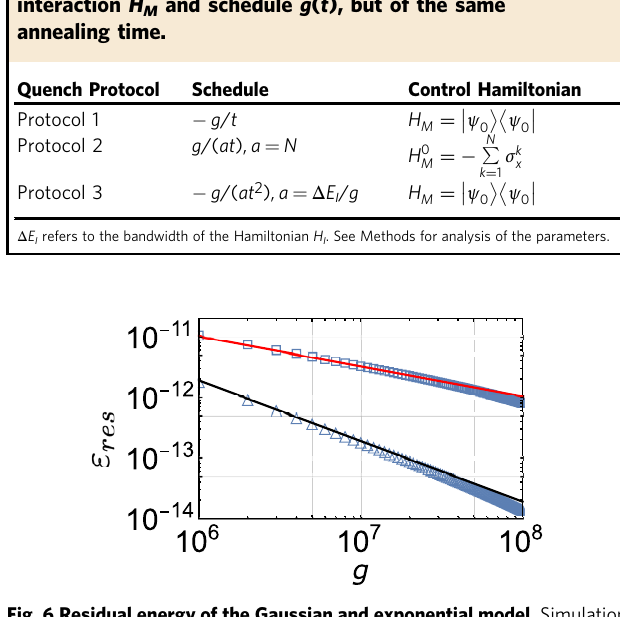
Fig. 6 Residual energy of the Gaussian and exponential model. Simulation of the residual energy for Gaussian (triangle) and exponential (square) spectral density, de fi ned in equations (45, 46). Red and black solid lines are ffiffiffi p (cid:7) 1 = g and ~1/ g , respectively. The total number of states is fi xed at N ¼ 10 9 .